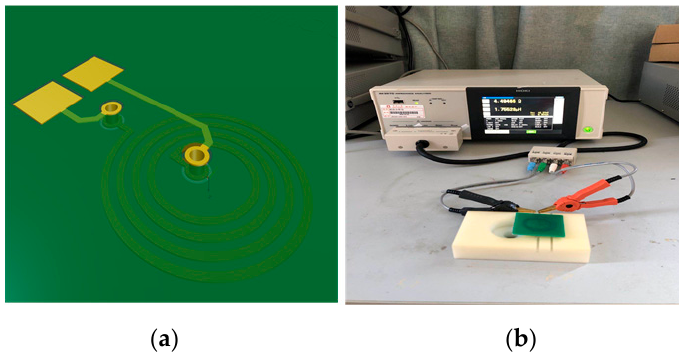
Figure 5. ( a ) Schematic view of the fabricated power inductor and ( b ) its experimental setup. Table 3. Comparison of the inductance results.